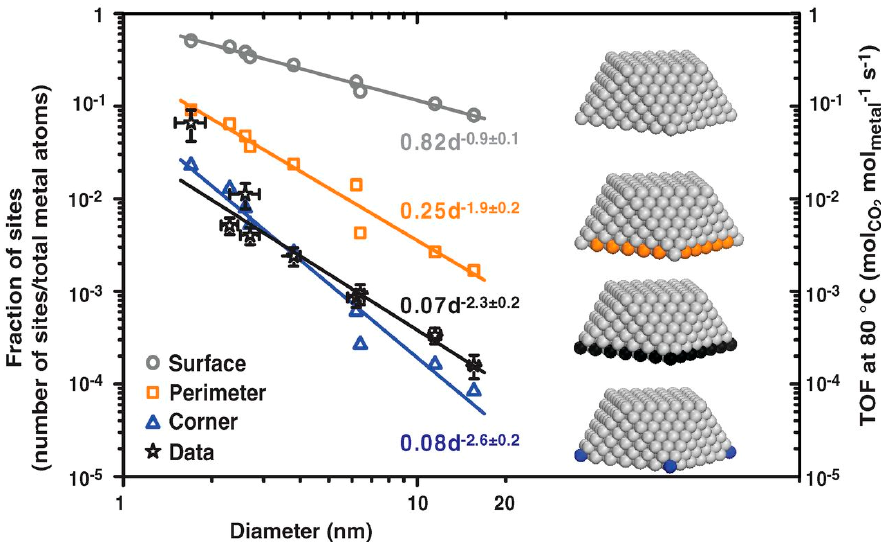
Figure 4. The calculated number of sites with a particular geometry (surface and perimeter or corner atoms in contact with the support) as a function of diameter and the turnover frequency (TOF) at 80 °C for ceria-based metals (Ni, Pd, Pt). Reproduced with permission from Reference [52]. Copyright © 2013, American Association for the Advancement of Science (AAAS).